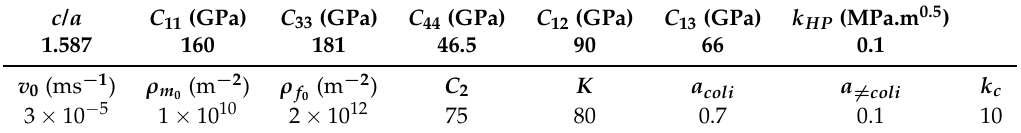
Table 3. Model parameters that are not specific to slip families. C ij are the stiffness constants. a coli denotes the interaction coefficient related to collinear interactions, i.e., reactions between dislocations with parallel Burgers vectors gliding in different planes, whereas a (cid:54) = coli refers to non-collinear interactions (see details in [19]). c /